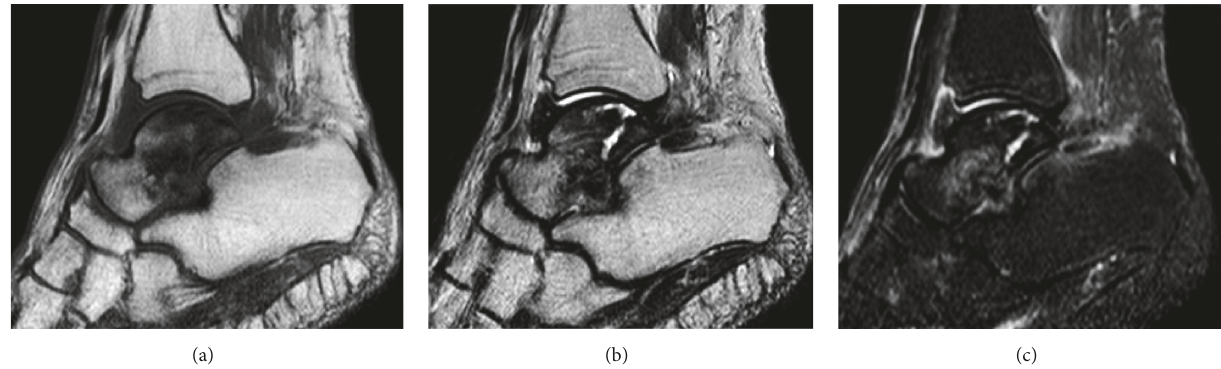
Figure 8: Preoperative MRI showing heterogeneous low signal intensity in the talar body on a T1-weighted image (a), a mixture of low and high signal intensity in the talar body on a T2-weighted image (b), and partial high signal intensity in the talar body on a STIR image (c).